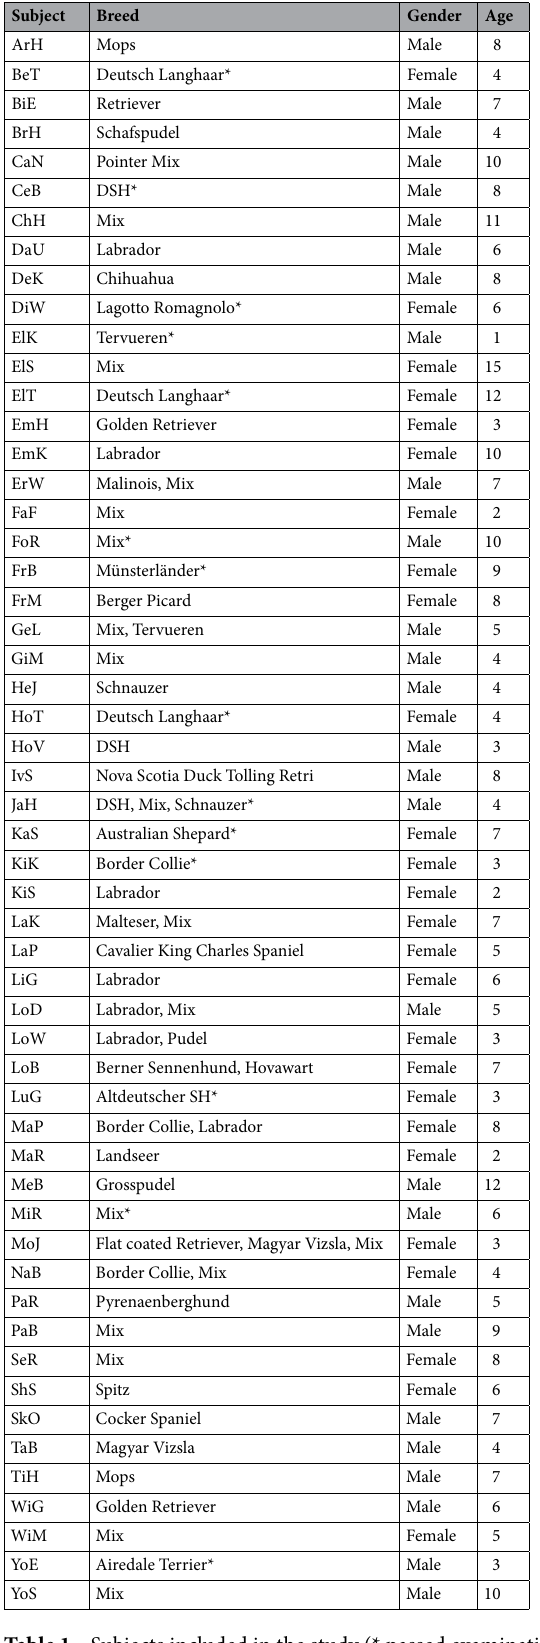
Table 1. Subjects included in the study (* passed examination for agility, guard dog, trail dog or hunting